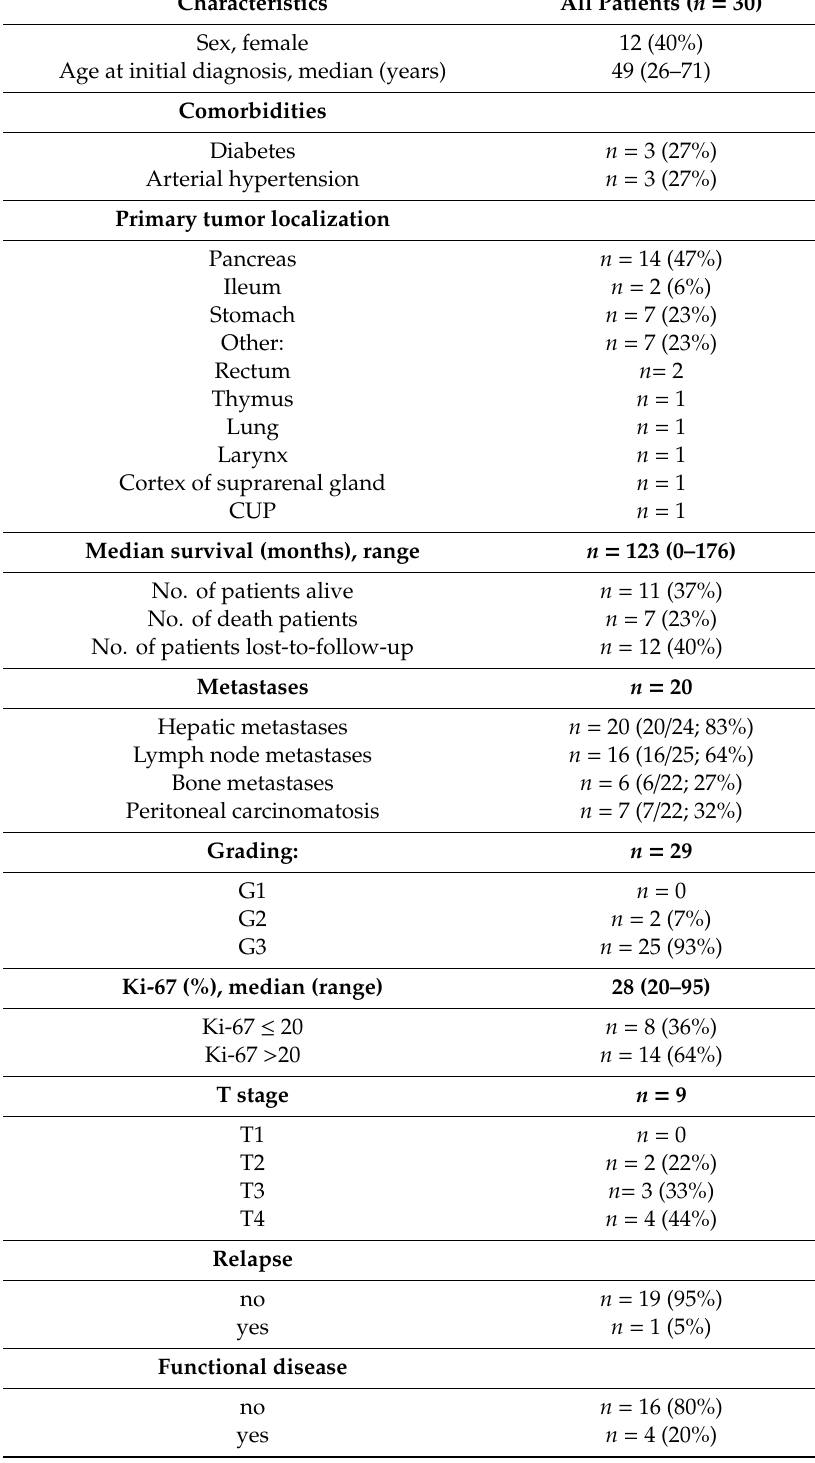
Table 2. NEC patients’